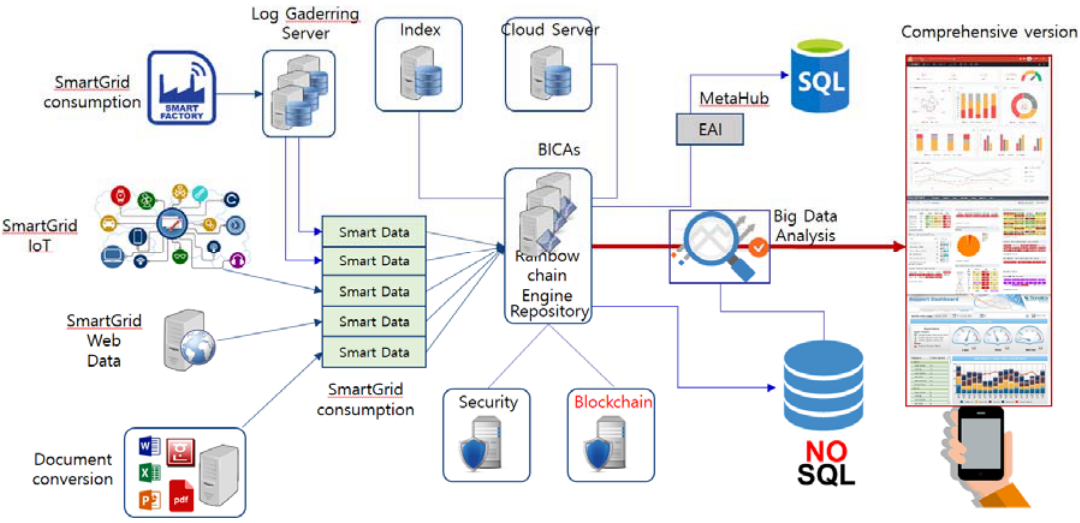
Figure 25. Rainbowchain architecture.